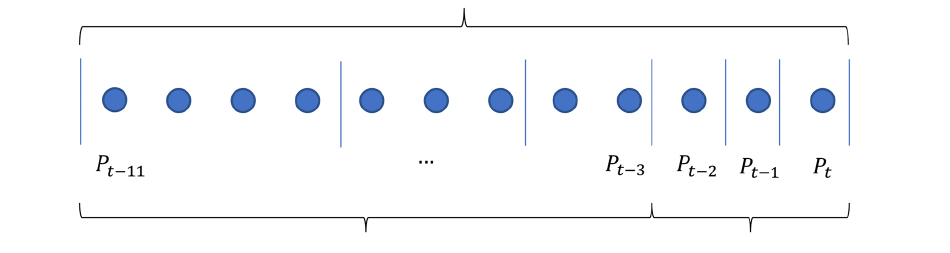
Representing a rainfall time series using a set of D t − a,t −